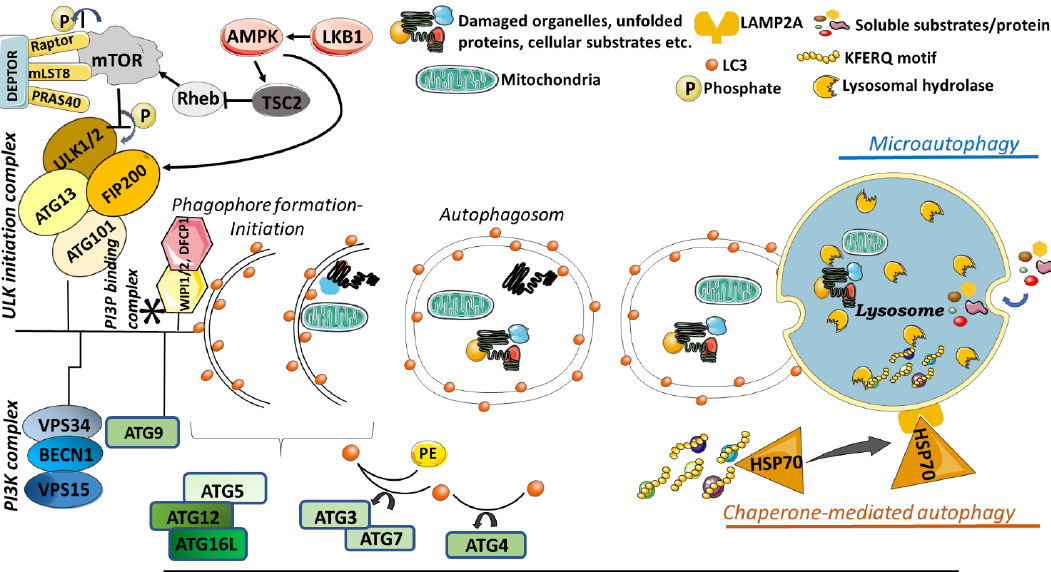
Figure 2. Illustration of main autophagy pathways. In macroautophagy, cellular contents are engulfed by double membrane vesicles called as autophagosome and carried to lysosome for degradation. In microutophagy, cytosolic components are directly taken into lysosome by lysosomal membrane invagination and degraded. In CMA, chaperon guiding proteins recognize target proteins and carry them to lysosome for degradation. mTOR: mammalian target of rapamycin protein, a highly conserved serine / threonine kinase, ULK1: Unc-51 Like Autophagy Activating Kinase 1, ULK2: Unc-51 Like Autophagy Activating Kinase 2 kinase, FIP200: focal adhesion kinase-family interacting protein of 200 kDa, PI3K: Complex of class III phosphatidylinositol 3-kinases, PI3P: Phosphatidylinositol-3-phosphate, AMPK: AMP-activated kinase, LKB1: liver kinase B1, Rheb: